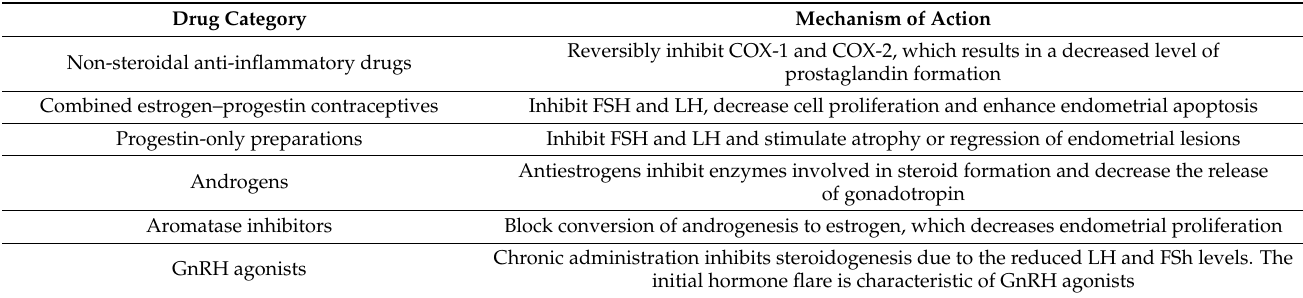
Table 1. Mechanism of action of drugs used in endometriosis